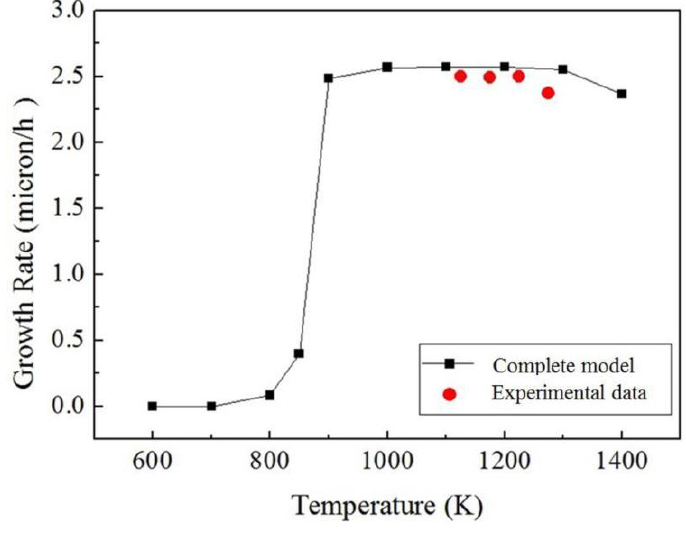
Figure 3. Result of the complete mechanism model vs. literature data [11].